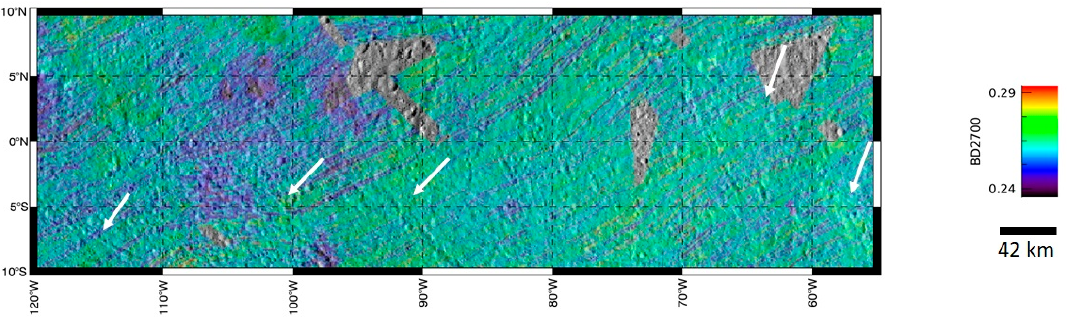
Figure 7. The 2.7 μ m band depth distribution of the Samhain Catenae region (cylindrical projection). The arrows indicate the linear features, which are not associated with band depth variations at all. Scale bar refers to the latitude at the map center.